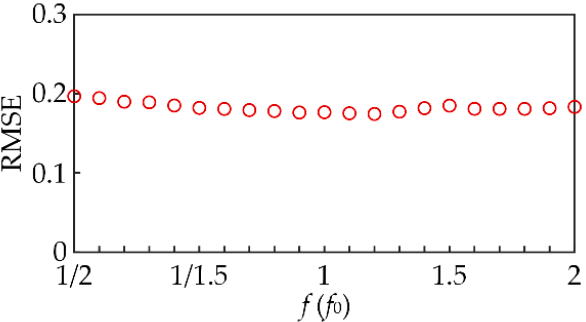
Figure 6. Graph of RMSE against frequency. The RMSE values between the holographic images and the desired image shown in Figure 2a are calculated using numerical simulation based on the combination of the FEM and the BEM. The studied frequency range is from f 0 /2 to 2 f 0